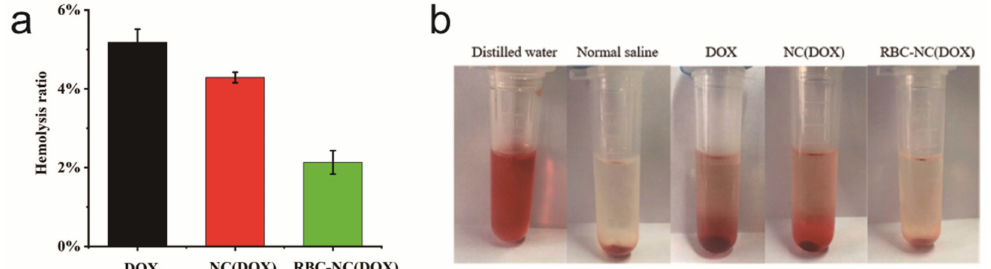
Figure 6. ( a ) The chart and ( b ) photo of the hemolysis of free DOX, NC(DOX), and RBC-NC(DOX). Error bars represent standard deviations (n =